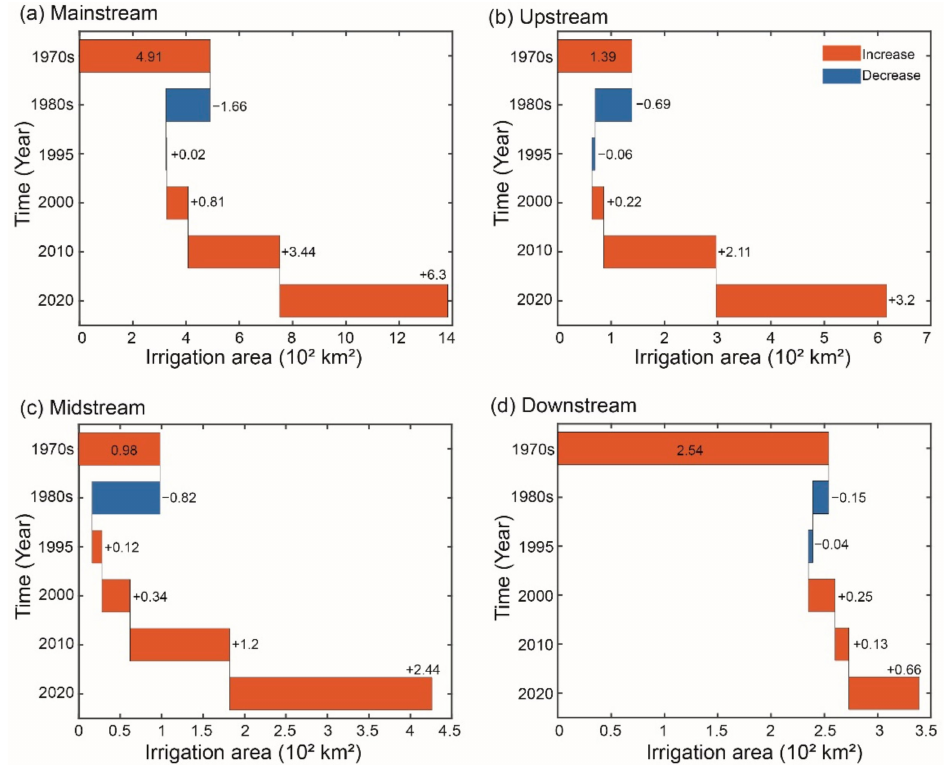
Figure 4. Area of irrigated land in the ( a ) mainstream, ( b ) upstream, ( c ) midstream, and ( d ) down- stream of the Tarim River Basin between 1970 and 2020. Red indicates the positive variation and blue indicates the negative variation in the irrigation area. The y -axis represents the decades and the x -axis is the irrigation